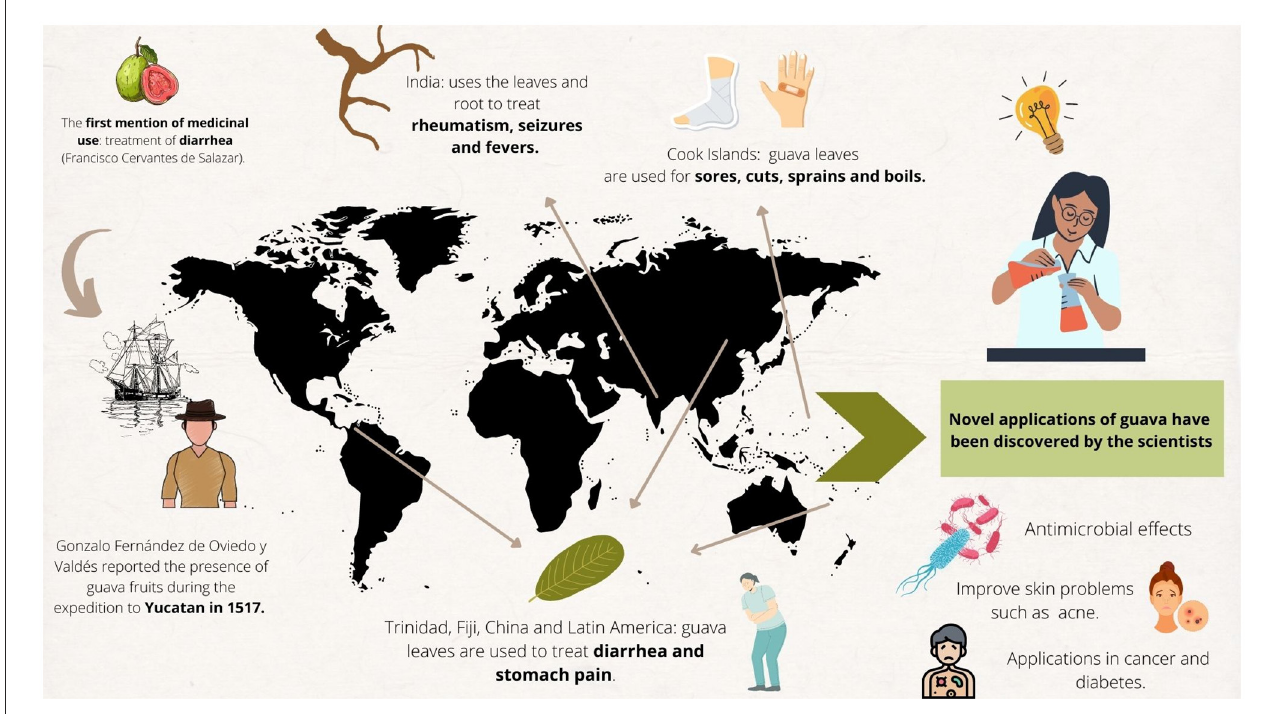
FIGURE2 Traditional uses of guava around the world and new perspectives and